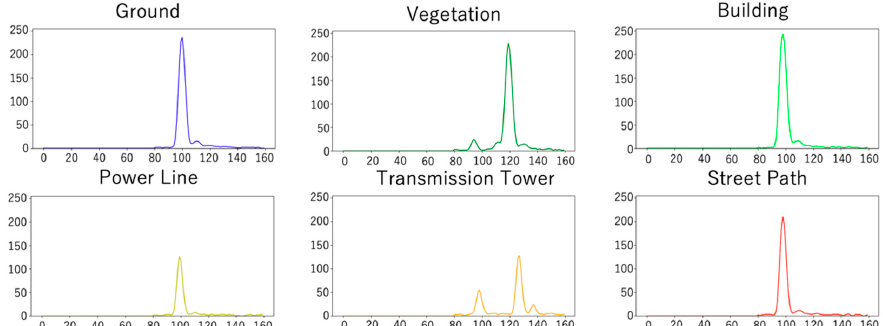
Figure 7. The training and test data used in this study. The red rectangle indicates the test area where we never used in the and parameter tuning process. The colors represent height values of the points from 24 m to 70 m.